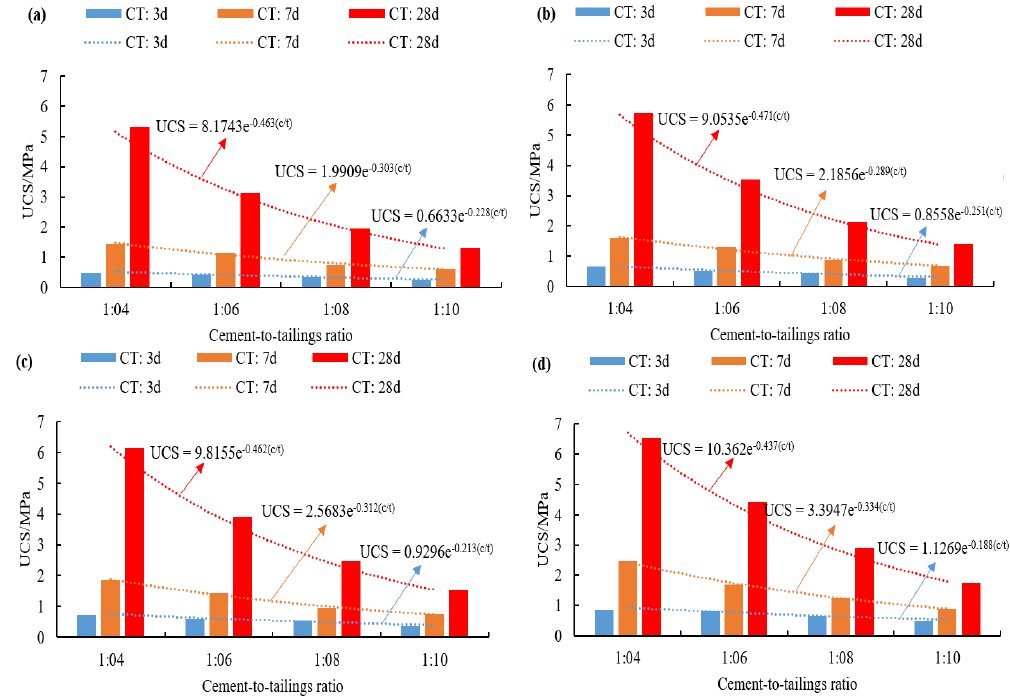
Figure 9. Relations between c/t and UCS of CTB: ( a ) SD: 65%; ( b ) SD: 68%; ( c ) SD: 70%; ( d ) SD: